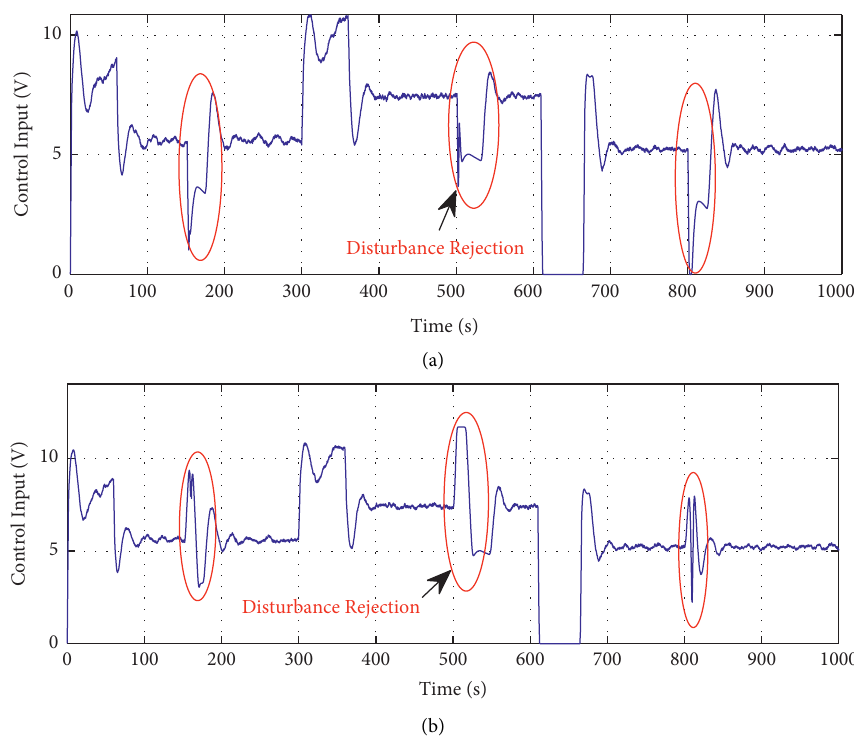
Figure 13: NTSM voltage with disturbances rejection. (a) With the reaction of rejecting the external disturbance; (b) with the reaction of rejecting the parameter